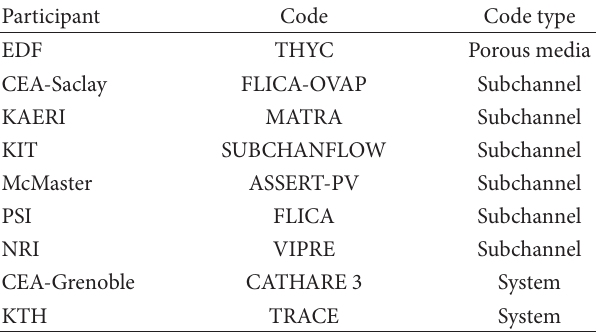
Table 16: Phase II, exercise 2 participants.